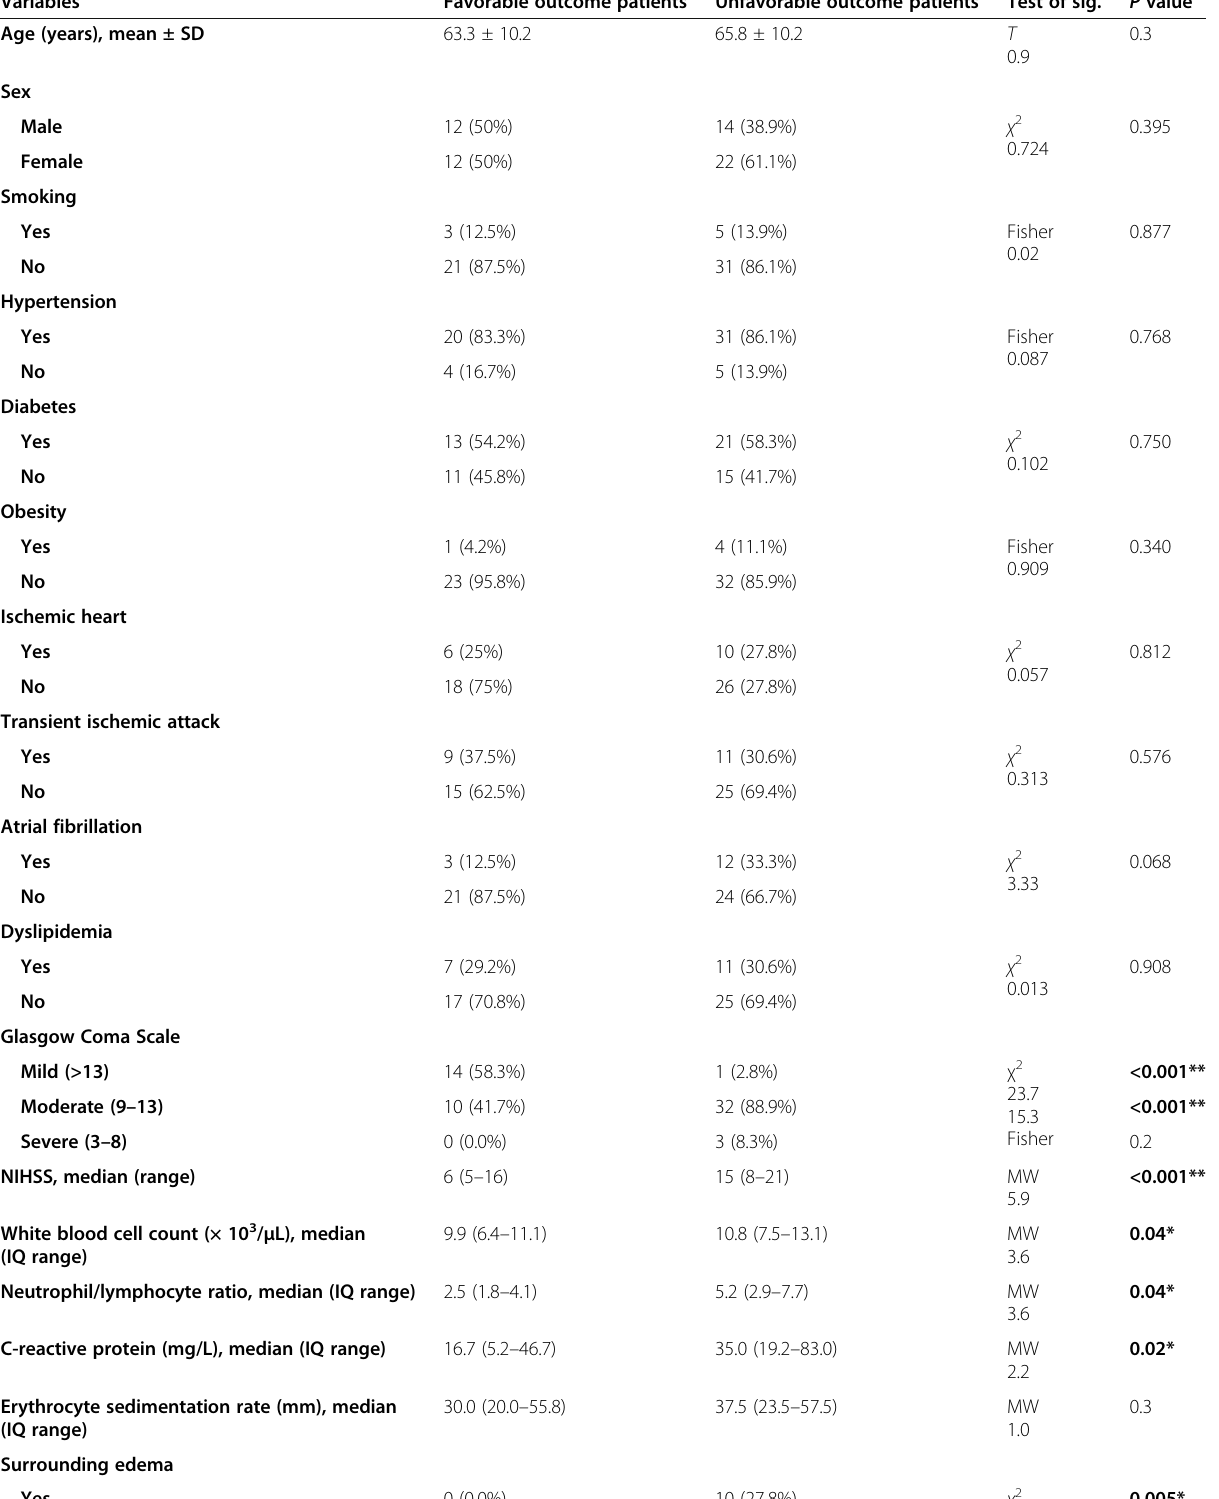
Table 1 Comparison between patients with favorable and unfavorable outcomes regarding inflammatory biomarkers, stroke severity, and short-term